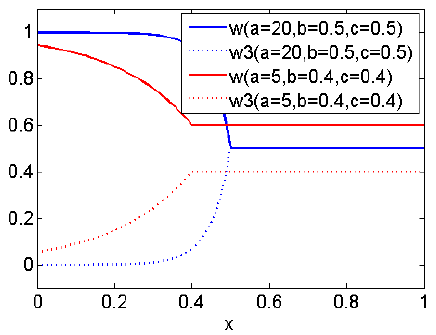
Figure 3. Illustration of the function w(x) and w3(x) = 1 − w(x) with different parameter setting of a, b and c.